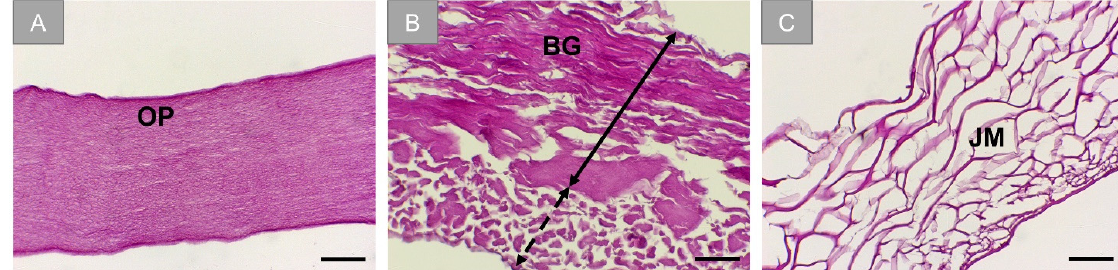
Figure 1. Histological visualization of the barrier membranes. ( A ) Ossix ® Plus (OP), ( B ) Bio-Gide ® (BG). Black double- headed arrow: compact layer, dotted double-headed arrow: porous layer. ( C ) Jason ® membrane (JM). (H&E stainings, scale bars: 50 µm, objective magnification: 20×).